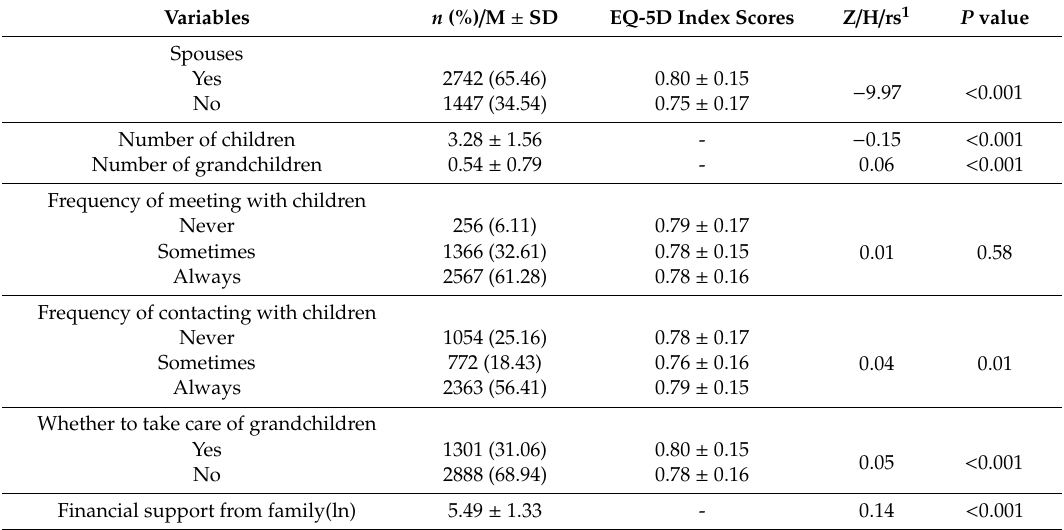
Table 3. The relationships between HRQOL and the quantity and quality of informal social